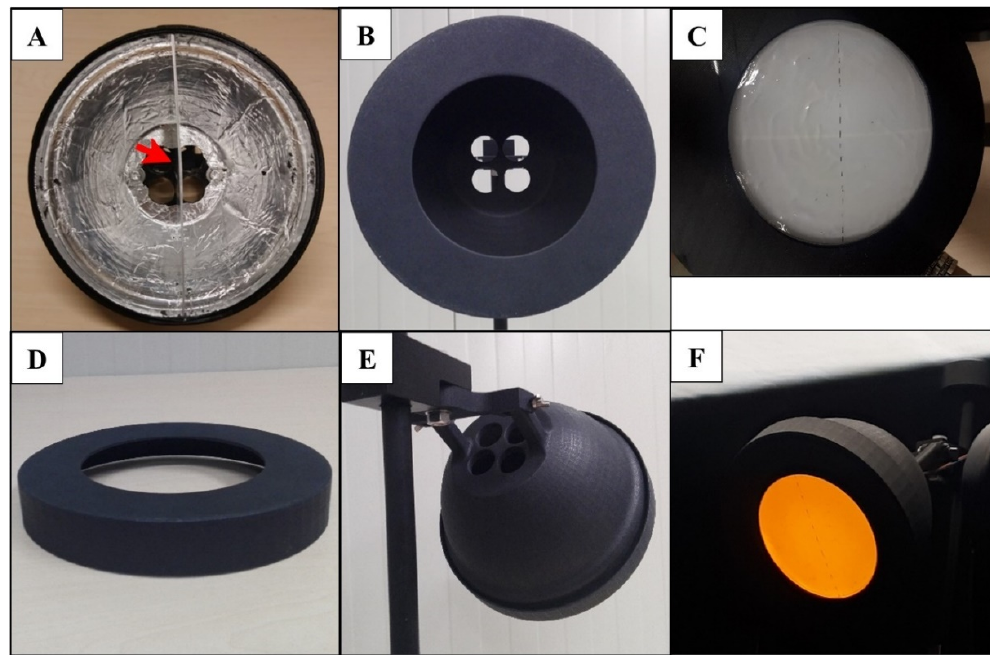
Figure 3. Aspects of the 3D printed dome housing the LEDs. ( A ) Frontal view showing the interior covered with aluminium foil, red arrow shows the division inside the dome. ( B ) Frontal view with the frame attached. ( C ) LED lamp with the diffusing glass plate and transparent propylene sheet with sticky glue. ( D ) Removable frame where the transparent sticky plastic was placed for catching the WFT. ( E ) Back side of the dome showing the four visible orifices where LEDs were placed. ( F ) LED lamp inside the wind tunnel shining a yellow and blue LED from inside the dome.